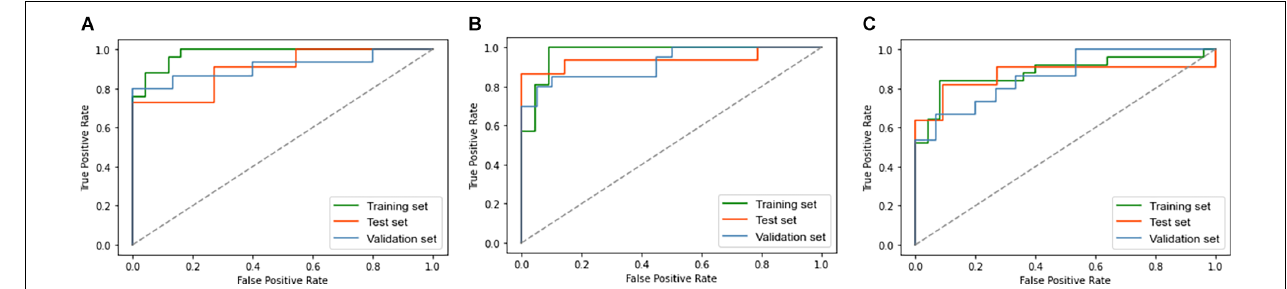
FIGURE 3 | The ROC curve of the EOAD-YC groups in the training and test and validation sets (A) . The ROC curve of the LOAD-OC groups in the training and test and validation sets (B) . The ROC curve of the EOAD-LOAD groups in training and test and validation sets (C) . ROC, receiver operating characteristic.